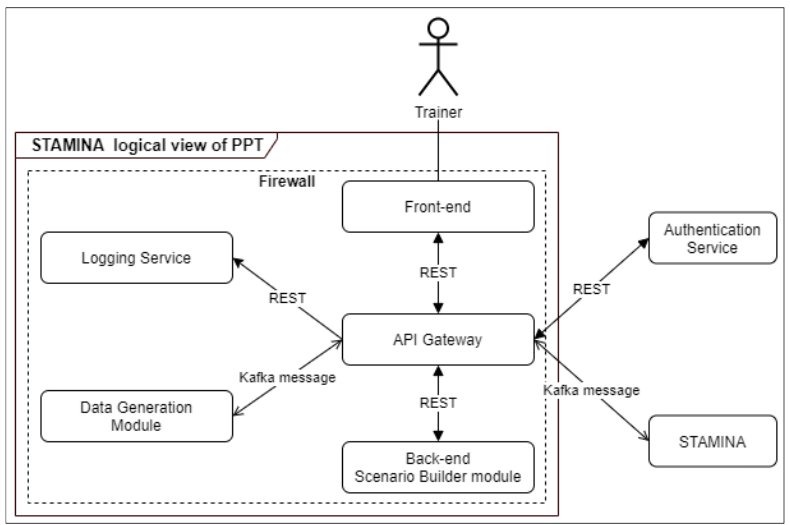
Figure 10. PPT tool architecture diagram.